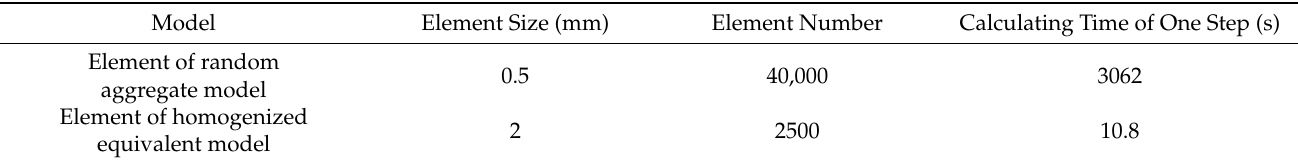
Table 3. Model data